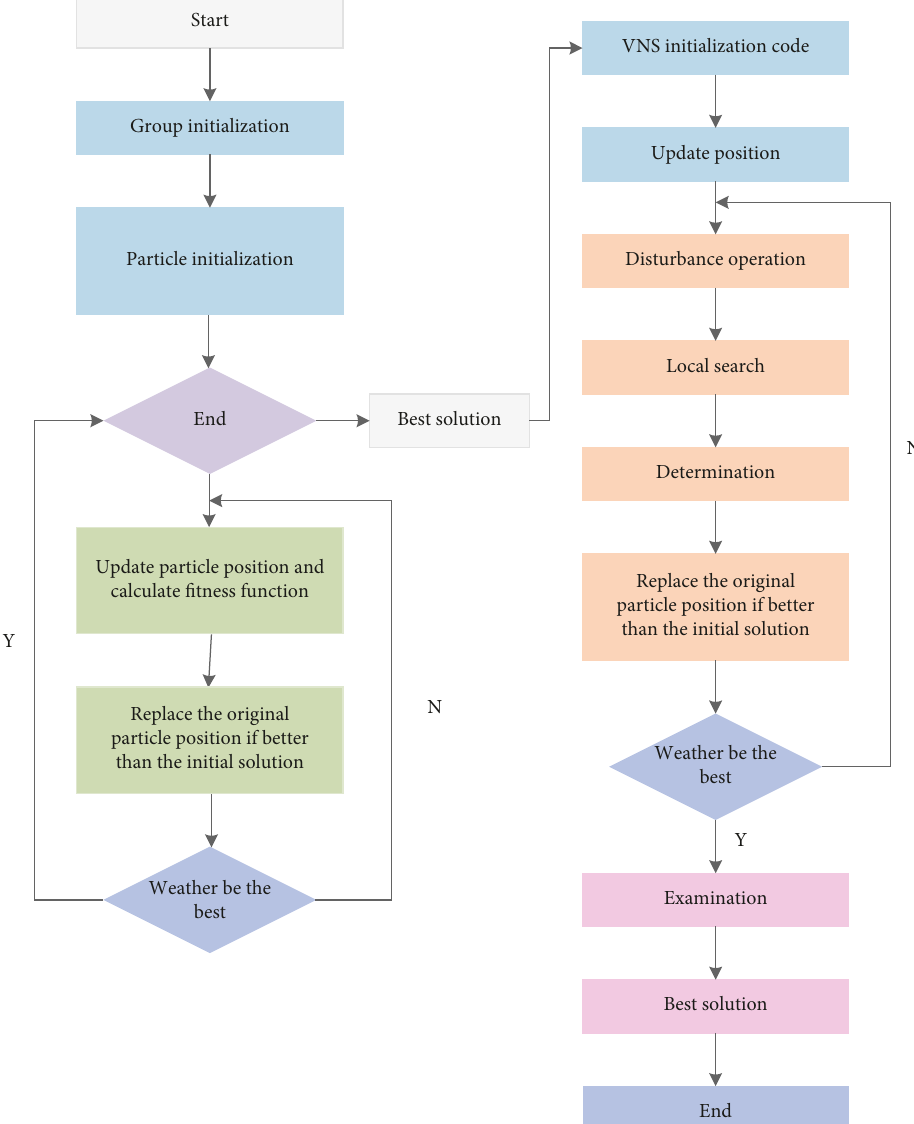
Figure 3: VNS algorithm